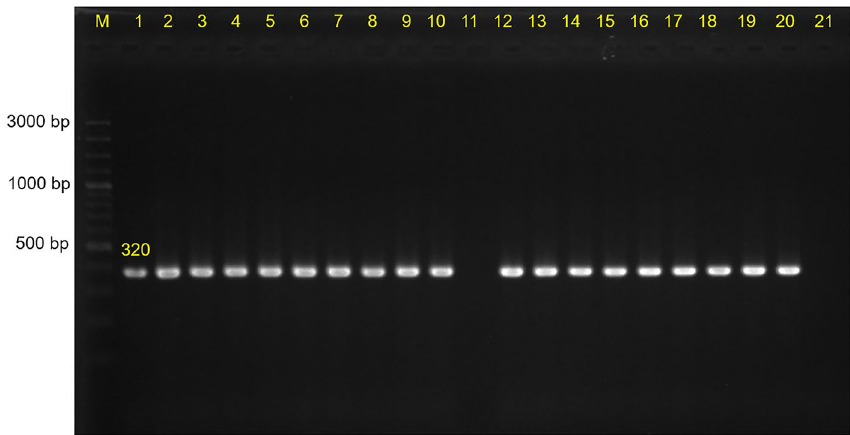
Figure 2. Agarose gel electrophoresis of PCR-amplified products from the transconjugants E. coli UB1637 . Conjugation assay was performed in mcr-1 -carrying CRE isolates. The transconjugants were collected nine colonies in each sample and confirmed the mcr-1 gene using PCR. Positive control (lane 1), E. coli strain no. 58967 (lane 2–10), negative control (lane 11), E. coli strain no. 56511 (lane 12–20), negative control (lane 22). A 100-bp DNA ladder is shown in lane M.